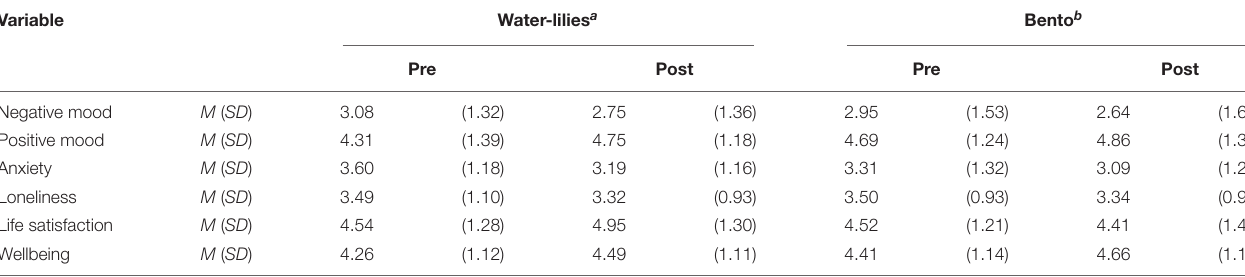
TABLE 1 | Average participant self-report ratings for each time condition per group (means and standard deviations).